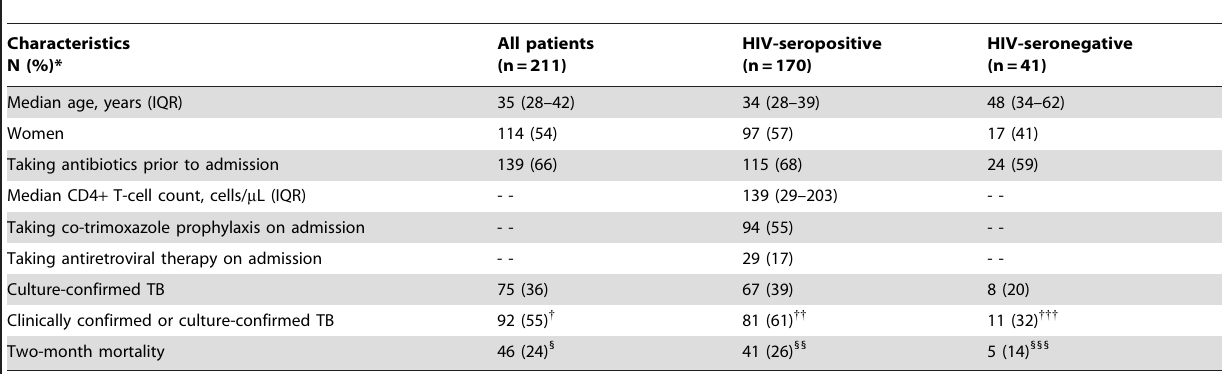
Table 1. Demographic and clinical characteristics of the 211 study participants.